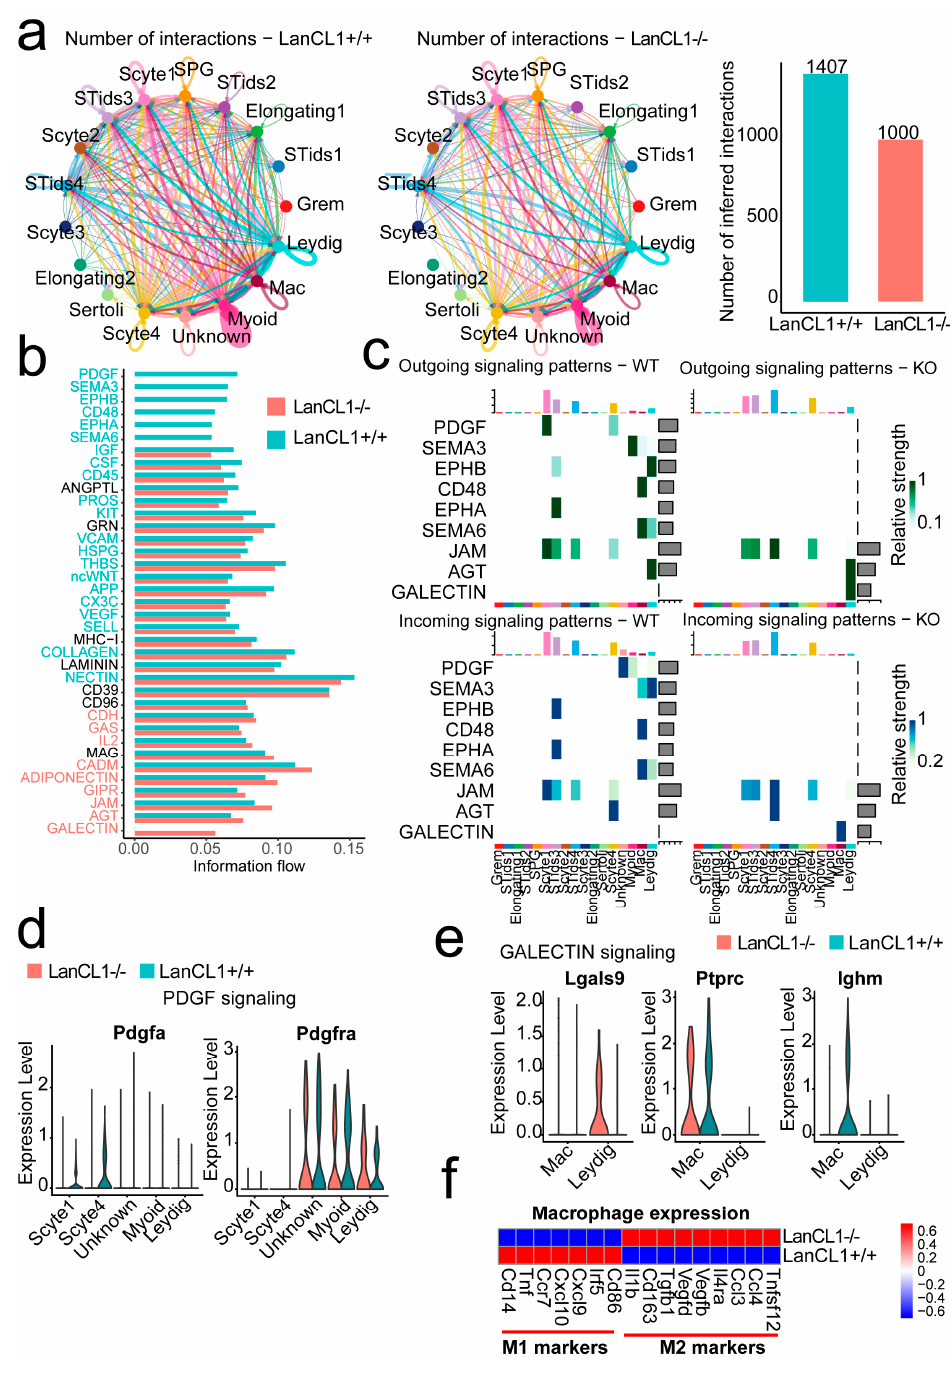
Figure 4. The cell interactions signaling in various cell clusters regulated by the LanCL1 gene. ( a ) The cell communication before and after LanCL1 gene knockout. ( b ) The alteration of signaling pathway. ( c ) Heatmap of the active signaling pathway in every cell clusters. ( d ) PDGF signaling pathway. ( e ) GALECTIN signaling pathway. ( f ) The M1 and M2 macrophage marker genes.